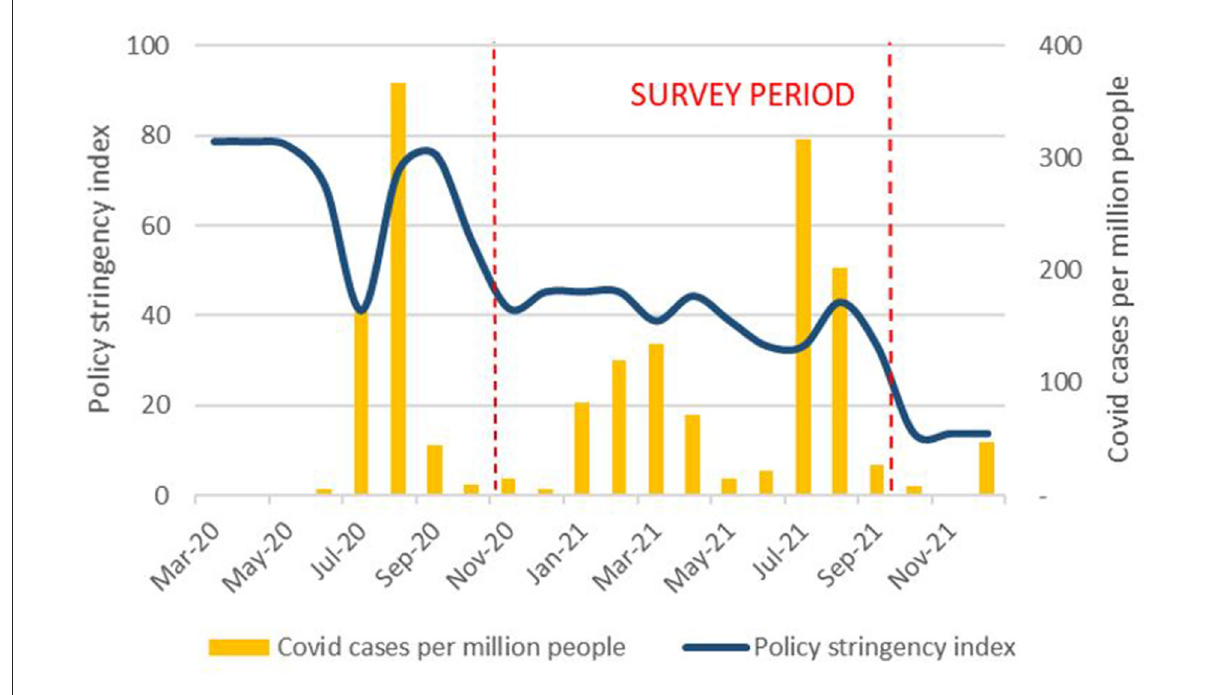
FIGURE1 Policy stringency and Covid cases [Own graph, data sources (40,